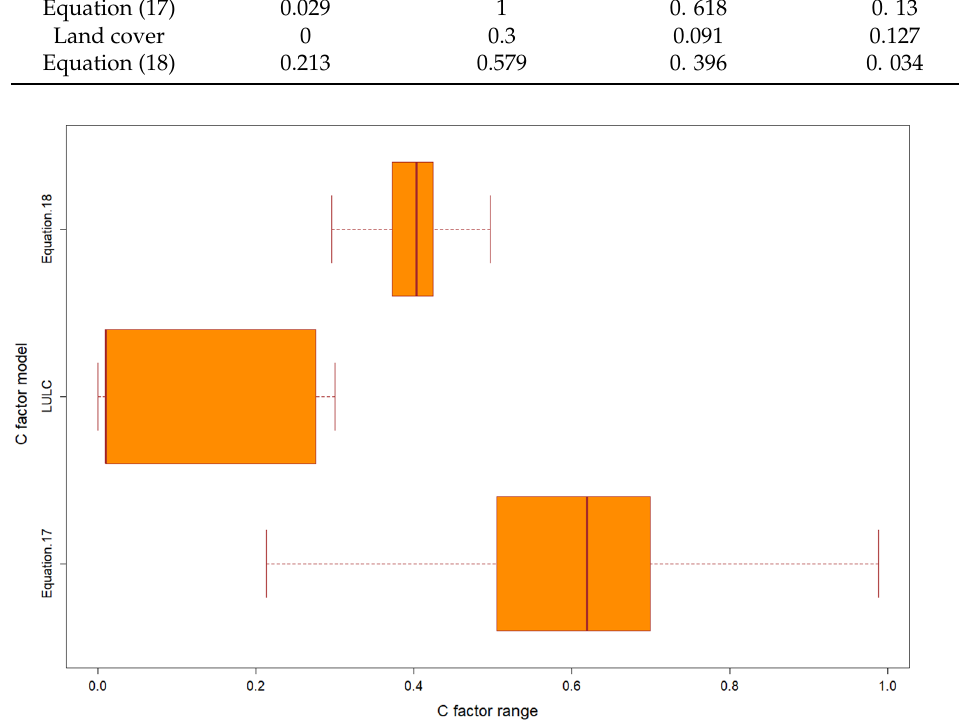
Figure 8. Boxplot shows the distributions of the ~5% random selected pixels from C-factor values for the three equations used in this study.